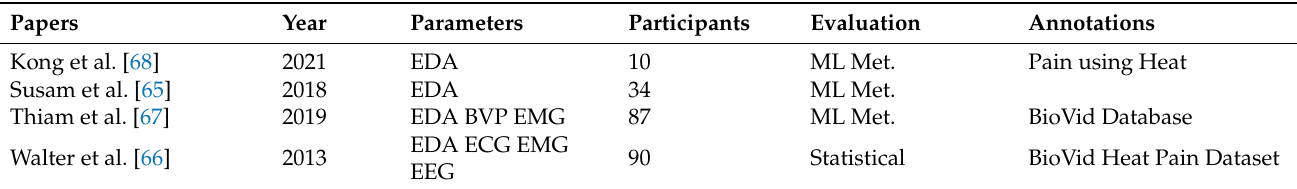
Table 7. Physiological signal used for physical pain detection.